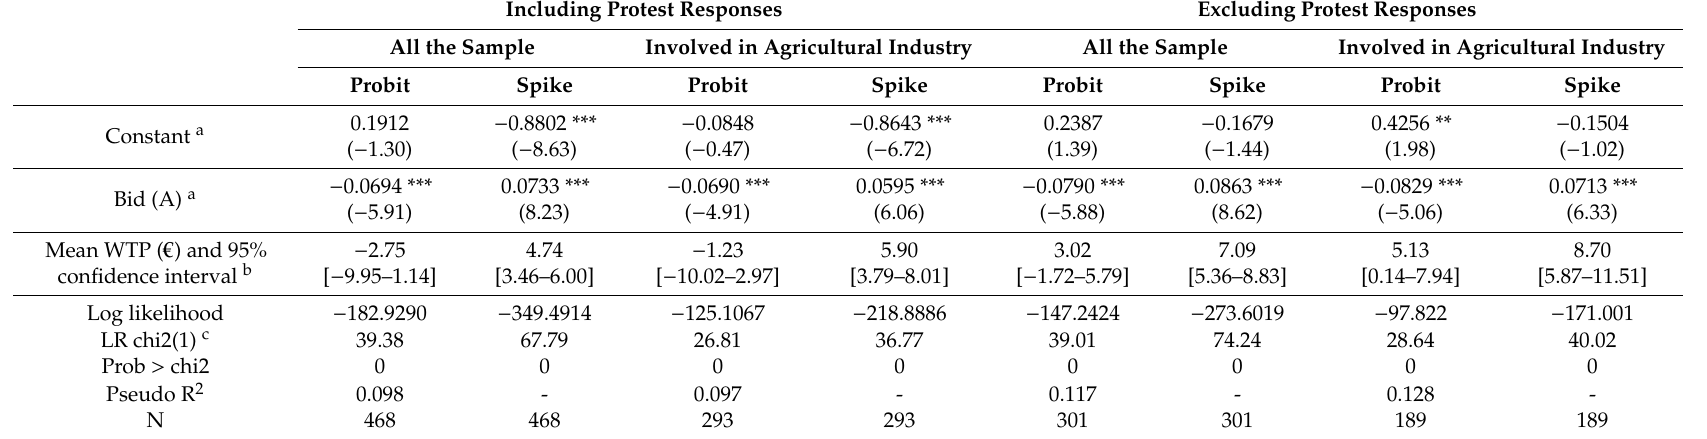
Table 4. Estimated models and mean